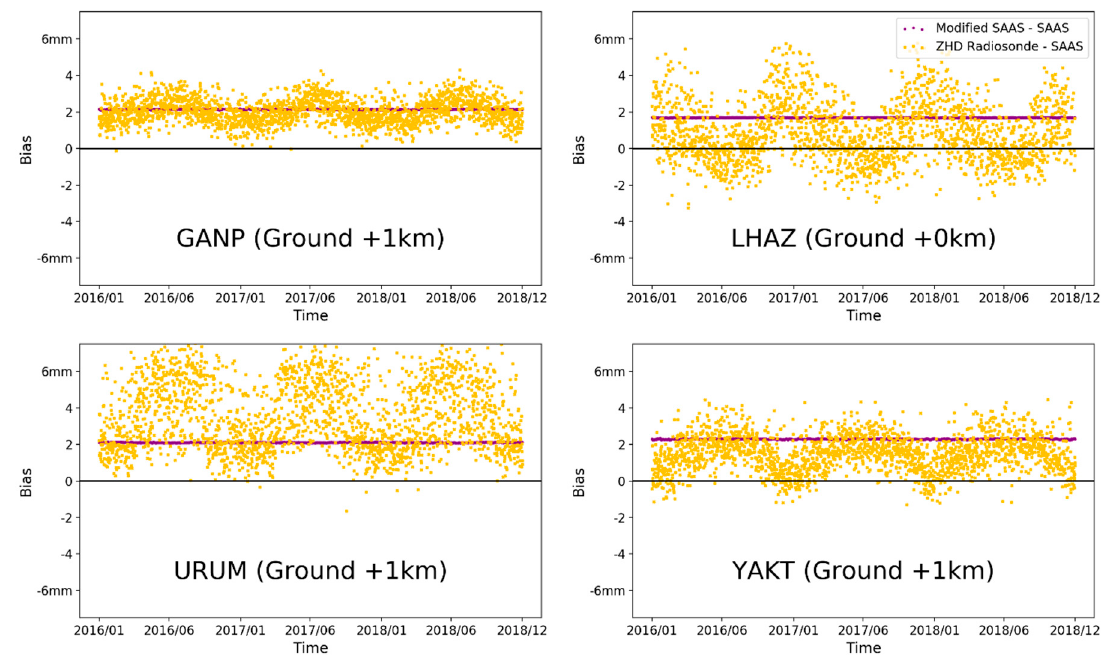
Figure 5. Seasonal biases examples for GANP station (Ganovce, Slovakia, altitude 703 m), LHAZ station (Lhasa, China, altitude 3650 m), URUM station (Urumqi, China, altitude 919 m), and YAKT station (Yakutsk, Russian, altitude 98 m). The series of differences were calculated at ground + 1000 m altitude, with the exception of the LHAZ station (ground